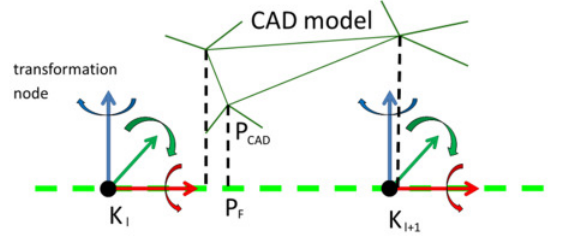
Figure 2. Schematic of point